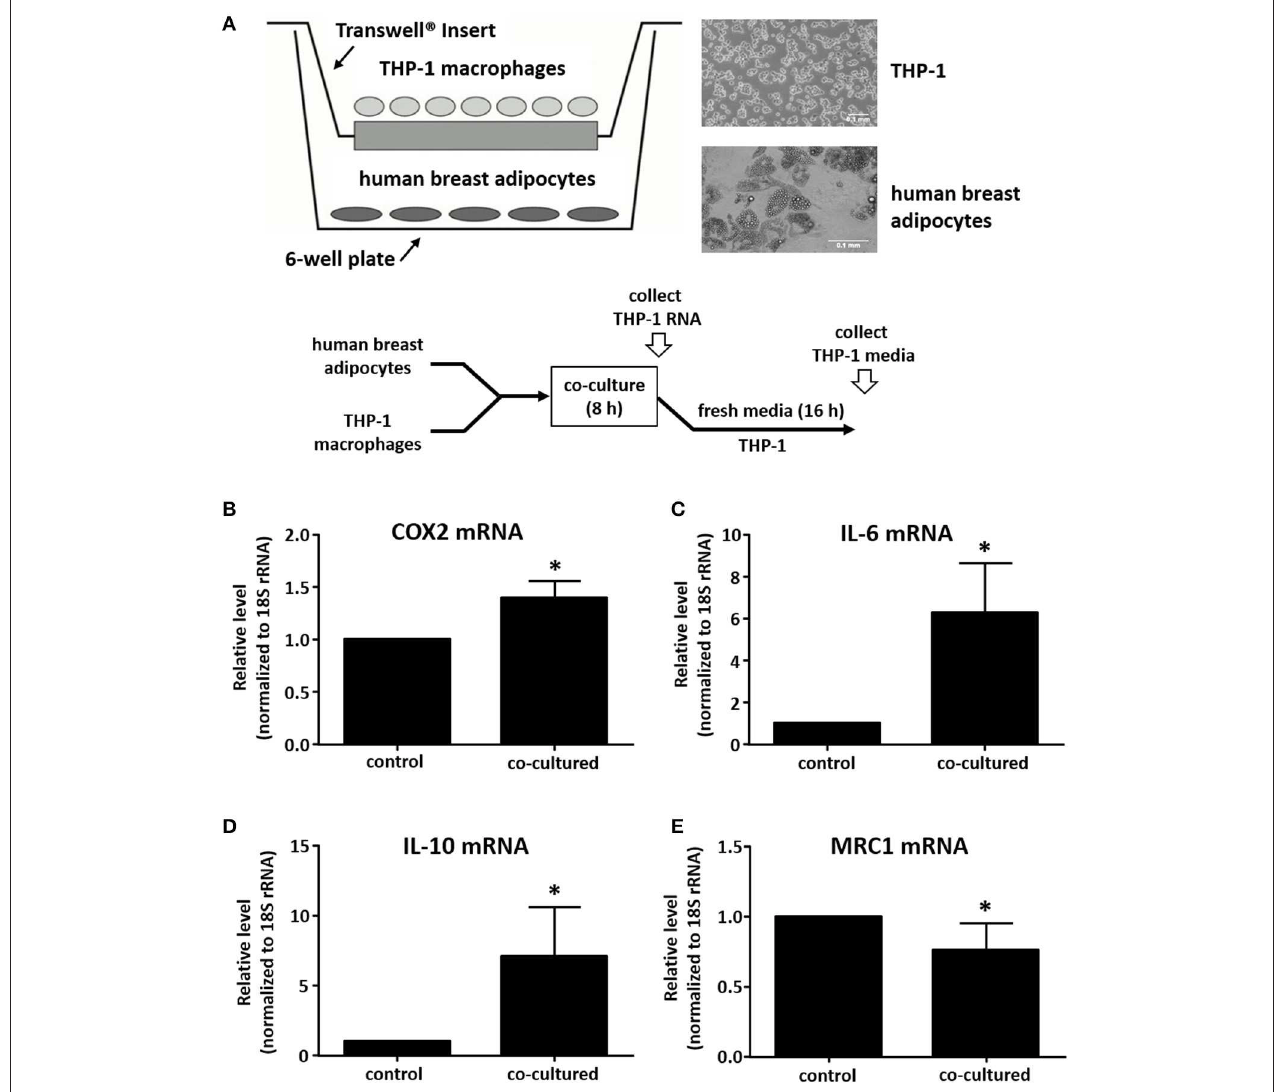
FIGURE 1 | Human adipocyte-macrophage co-culture system and phenotype determination of adipocyte-exposed macrophages. (A) Diagram showing co-culture system where differentiated primary human breast adipocytes were cultured in the lower chamber, PMA-differentiated THP-1 were cultured on a Transwell insert, and co-culture was performed for 8h prior to RNA collection. THP-1 mRNA levels were analyzed by real time qPCR to determine expression of COX2 (B) , IL-6 (C) , IL-10 (D) , or MRC1 (E) ; values were normalized to 18S RNA, n = 4, * p < 0.05, statistical analyses were performed using standard deviation and the unpaired Student’s t